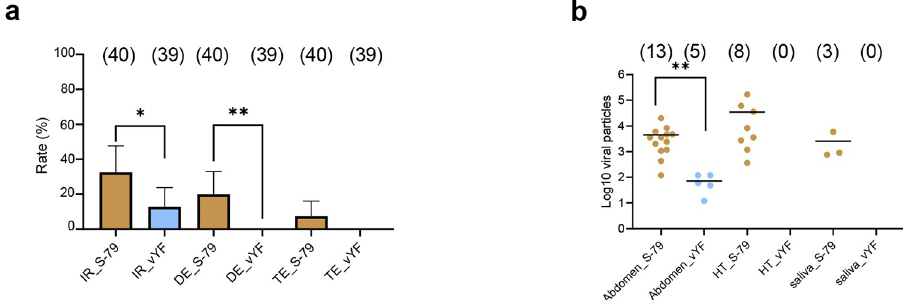
Fig 4. Infection rate, dissemination efficiency, transmission efficiency (a), Log 10 viral particles in abdomen, head and thorax, and saliva (b) of Aedes albopictus Tainan (Taiwan) exposed to vYF-247 and S-79 strains. Mosquitoes were presented to a blood meal at a titer of 10 7.5 ffu/mL and examined at 21 days post-infection. In brackets, number of tested mosquitoes for IR, DE, TE, and number of YFV-positive abdomens, HT and saliva. Stars indicate statistical significance of comparisons: � p � 0.05, �� p �